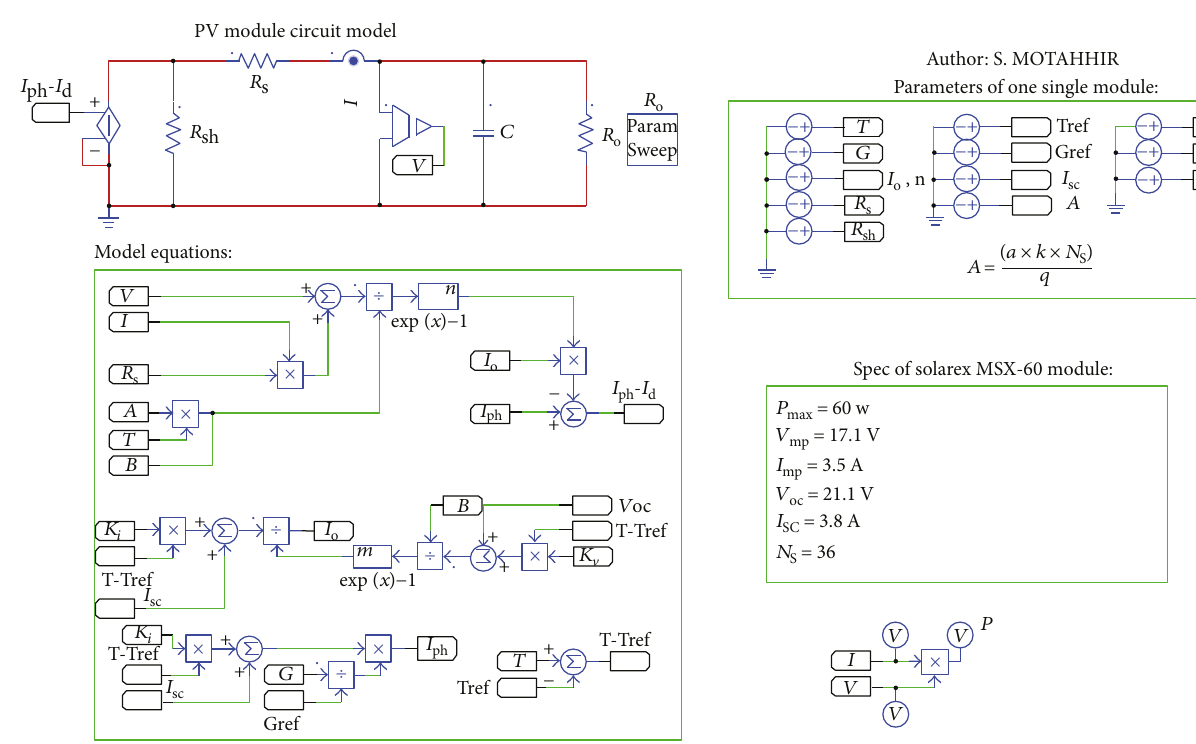
Figure 3: PV panel PSIM model.